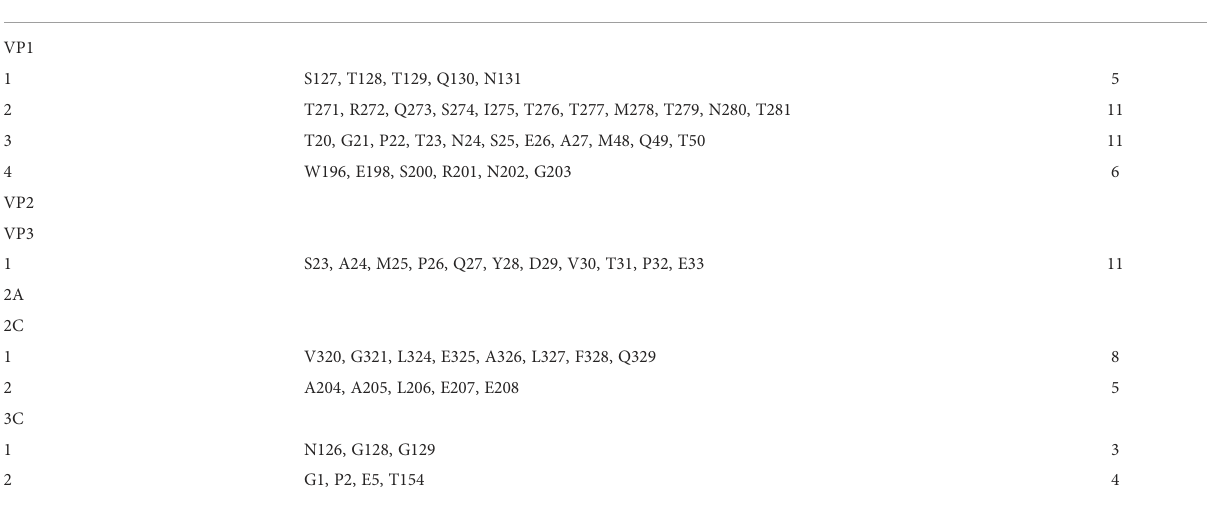
TABLE 5 Predicted conformational B-cell epitopes of CVB proteins. Protein